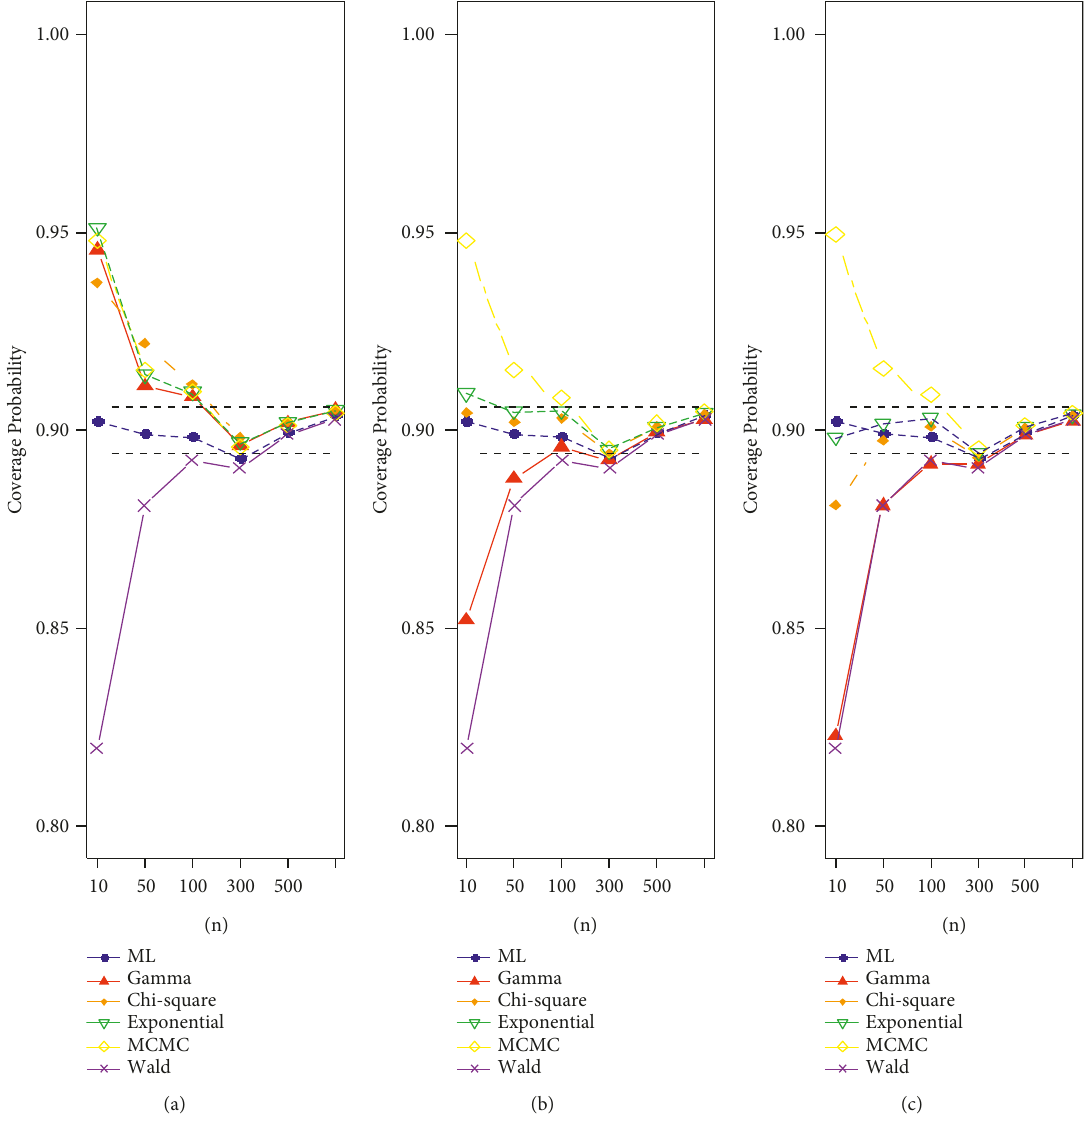
Figure 3: The trend of CP for all methods varies by the sample sizes at 90% confidence interval. (a) Variance � 2. (b) Variance � 4. (c) Variance �